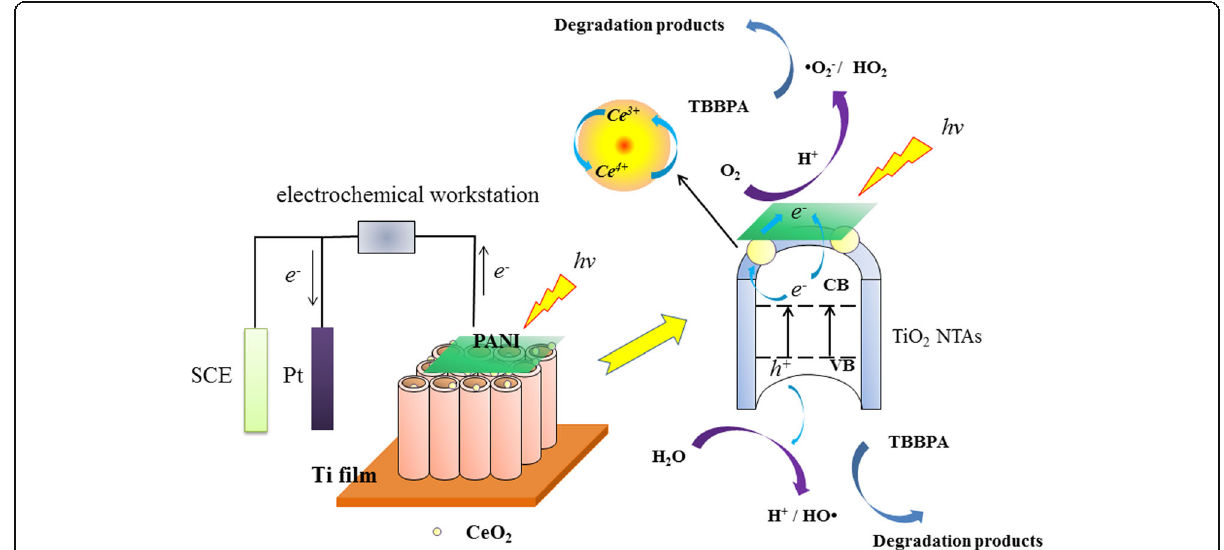
Fig. 7 Degradation mechanism of TBBPA on PANI/CeO 2 /TiO 2 NTAs under simulated